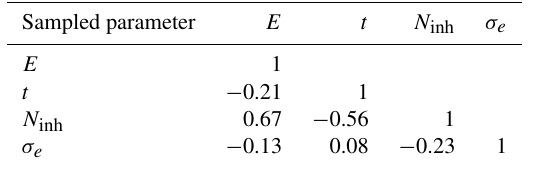
Table 2. Posterior linear correlation coefficients between the four parameters sampled using our